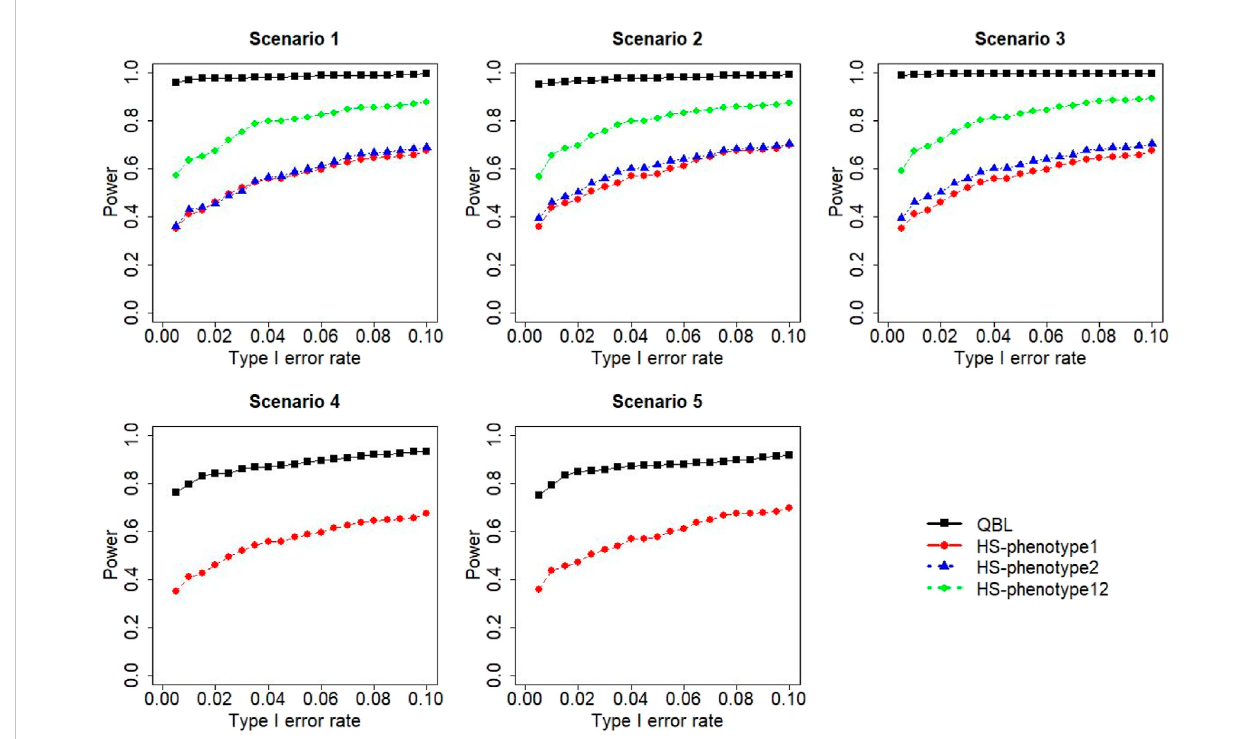
FIGURE 10 Simulation results under sample size 1,000, setting 2 (12 haplotypes), and ρ = 0.1. Scenarios are shown in Table 1. HS, Haplo.score; phenotype12: phenotype 1 or